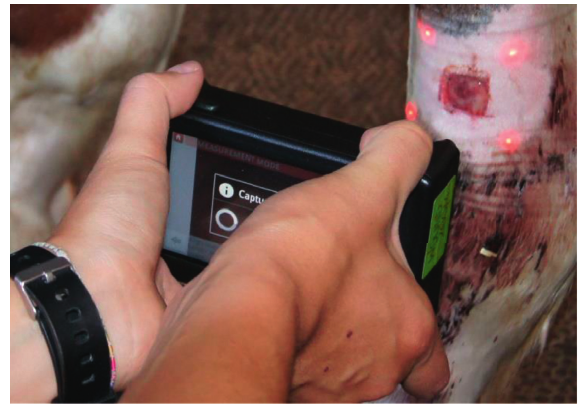
Figure 3: Digital image. The four laser beams of the device were projected and aligned outside of the wound border. After con- necting the camera to a computer, images were treated by specific